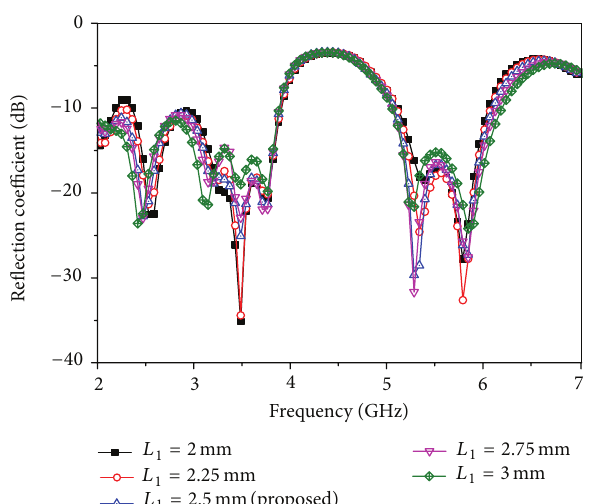
Figure 7: Effect of reflection coefficient for the different length of ground slit 𝐿 1 .